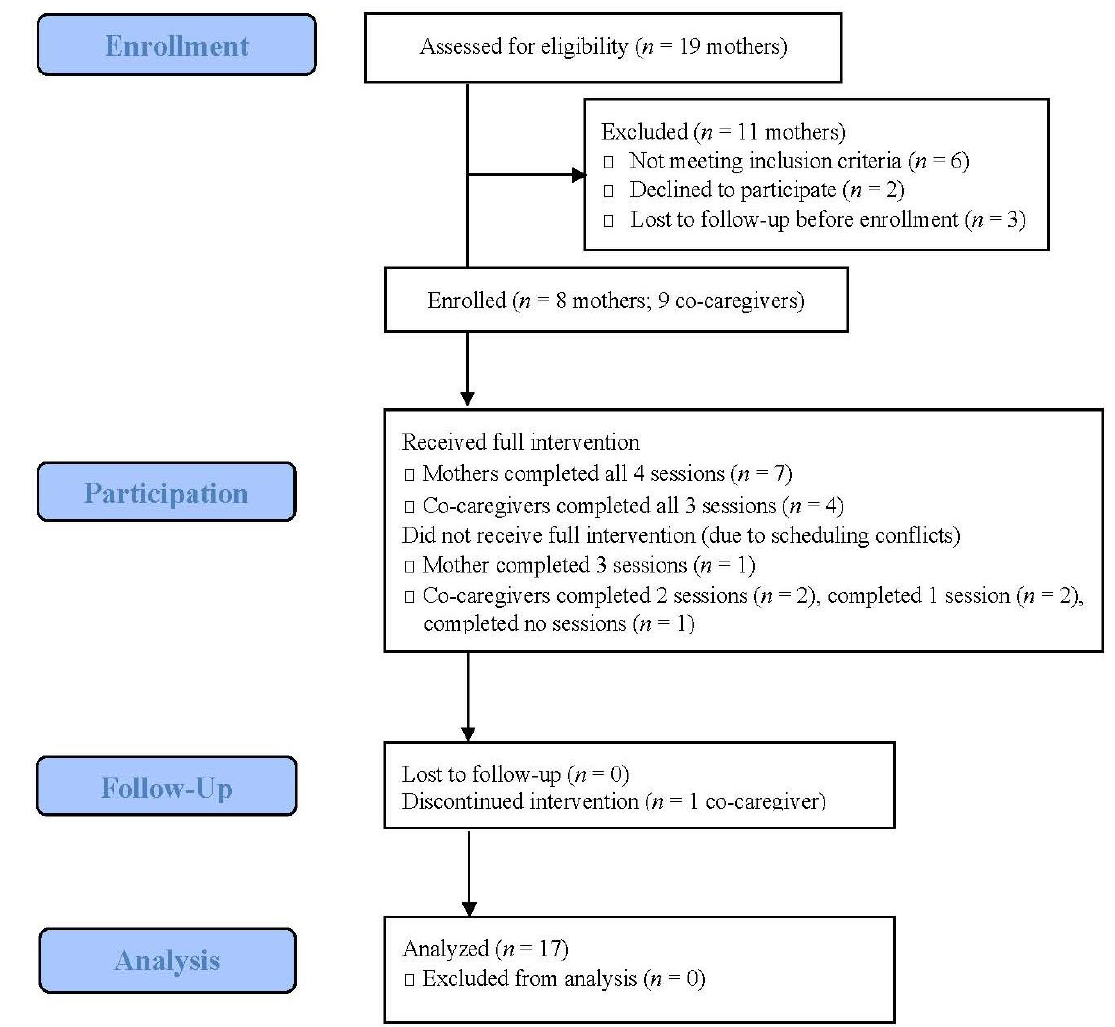
Figure 1. CONSORT 2010 Flow Diagram, modified for non-randomized trial design.